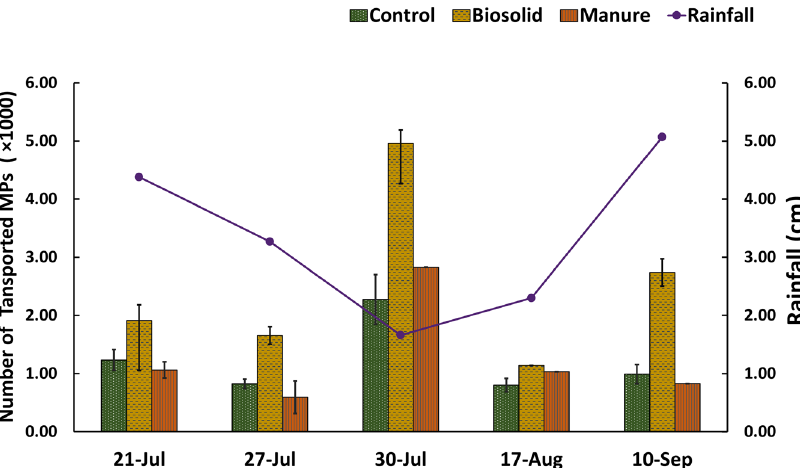
Fig. 2 Rainfall quantities across different sampling dates (purple line) and the occurrence of MPs in runoff from control (green), biosolid (yellow), and manure (red) plots. Bars represent the average number of transported MPs and error bars represent the maximum and minimum number of transported MPs in each